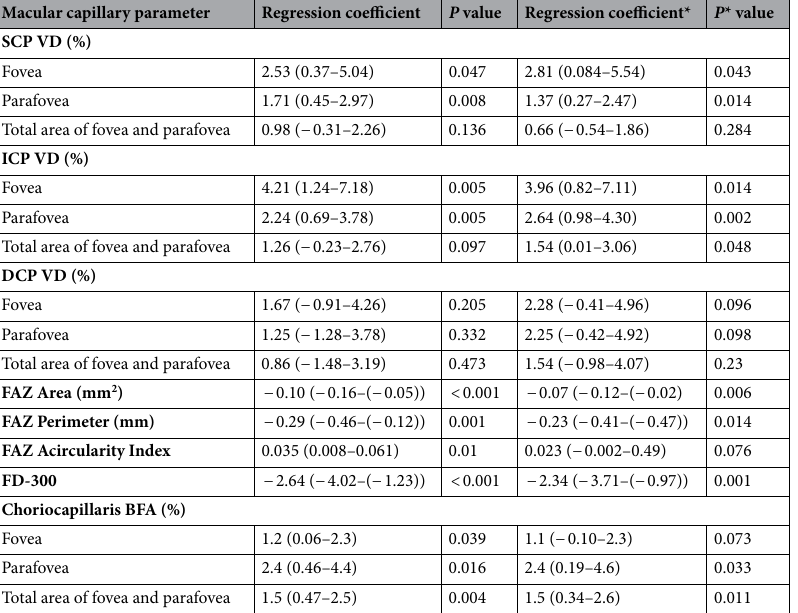
Table 2. Mixed-effects linear regression analysis of the association between race and mean macular capillary parameters. Regression Coefficient and P value accounting for 2 eyes of the same subject. Regression Coefficient* and P* value accounting for 2 eyes of the same subject and adjusting for axial length. VD = vessel density. SCP = superficial capillary plexus. ICP = intermediate capillary plexus. DCP = deep capillary plexus. FAZ = foveal avascular zone. FD-300 = capillary density in a 300 μm wide region around the FAZ. BFA = blood flow